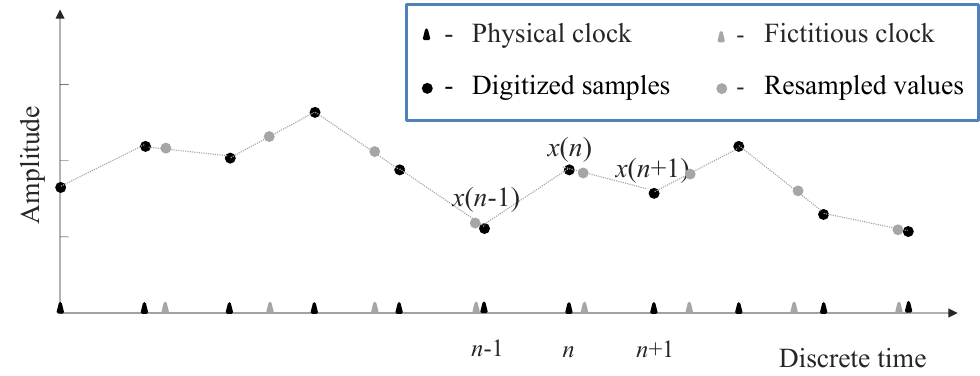
Figure 1. Samples produced by the ADC at the time instants ticked by the physical clock, and resam- pled values at time instants ticked by the fictitious